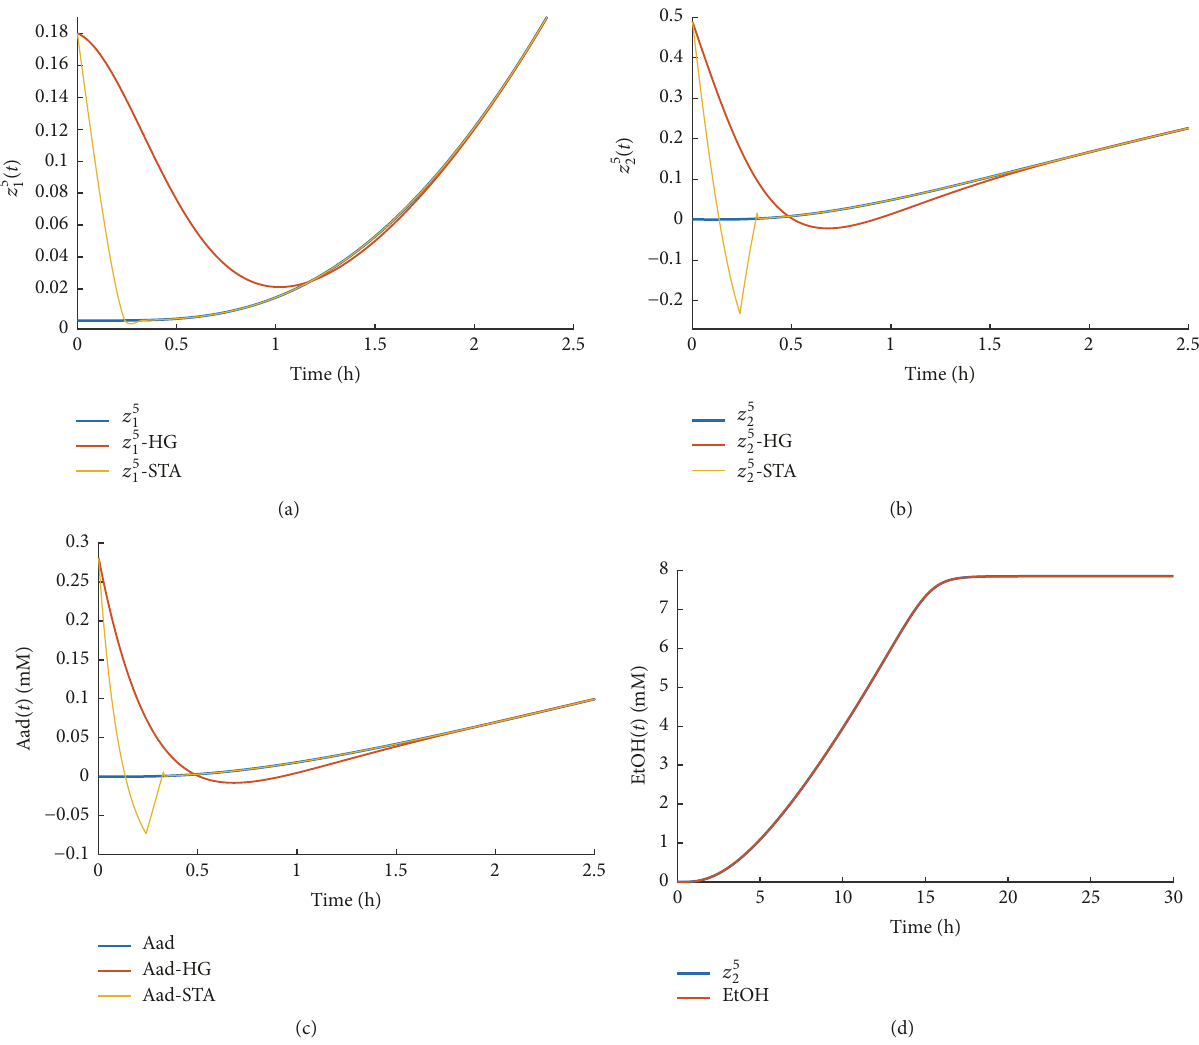
Figure 5: Detailed simultaneous visualization for the states of the transformed coordinates in the third subsystem, the corresponding high- gain observer, and the STA-based estimator: (a) 𝑧 4 1 and (b) 𝑧 4 2 during the first 5 hours. (c) and (d) depict the detailed variation of the concentrations for the compounds (c) Aad and (d) EtOH as well as their estimates produced by the inverse transformation applied to both the high-gain and the STA-based observer during the first 5